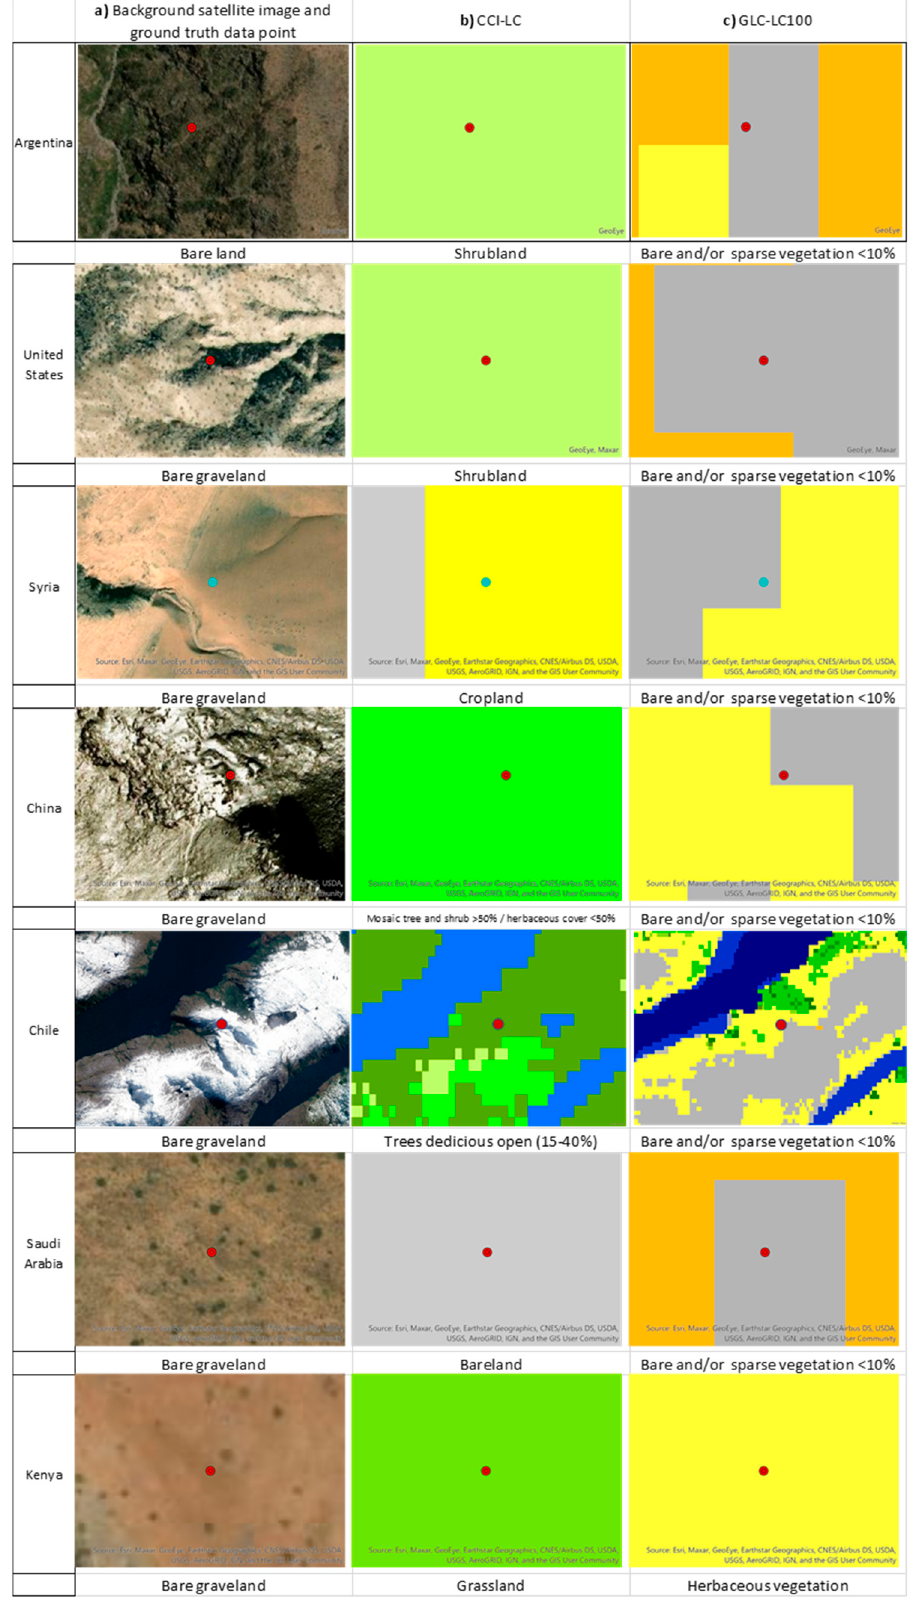
Figure A2. Selected sites associated with omission errors from the accuracy assessement of the green/non-green map: ( a ) background very high-resolution images from Google/ESRI; ( b ) land cover classified according to CCI-LC 2015; ( c ) land cover classified according to CGLS-LC100 2015.